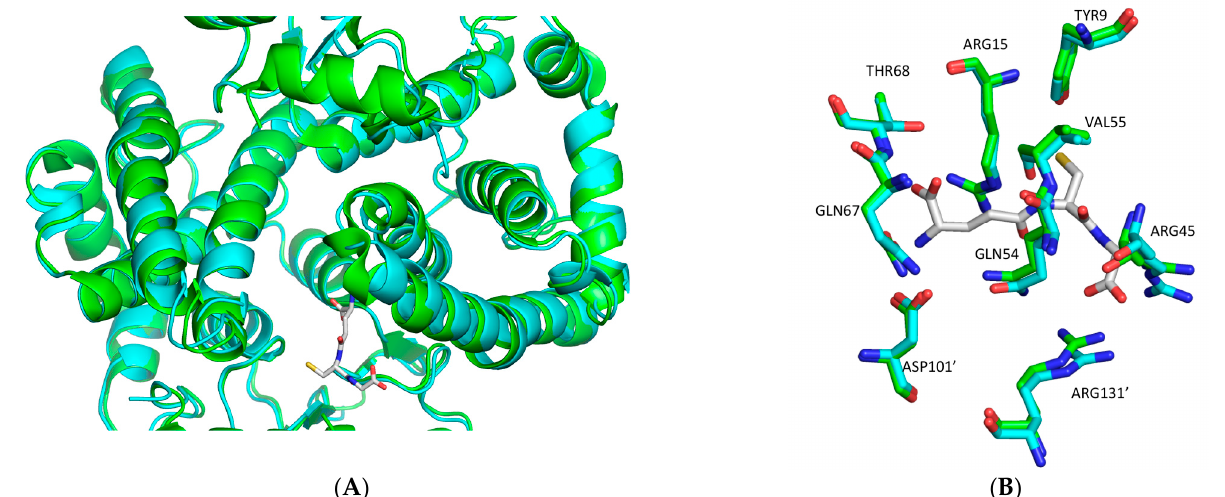
Figure 8. ( A ) Structural superposition of hGSTA1-K141H/S142H (cyan) onto hGSTA1-1 − GSH (green) (PDB code: 1PKW) [28]. GSH is shown in stick representation. ( B ) Close-up comparison of hGSTA1-K141H/S142H and hGSTA1-1 (PDB code: 1PKW) active sites after superposition. The residues that are involved in GSH binding are Tyr9, Arg15, Arg45, Glu54, Val55, Gln67, and Thr68, and Asp101 ′ and Arg131 ′ from the second subunit. The structures of hGSTA1-K141H/S142H and hGSTA1-1 − GSH are colored in cyan and green, respectively. The analysis was carried out using PyMOL Molecular Graphics System [30].